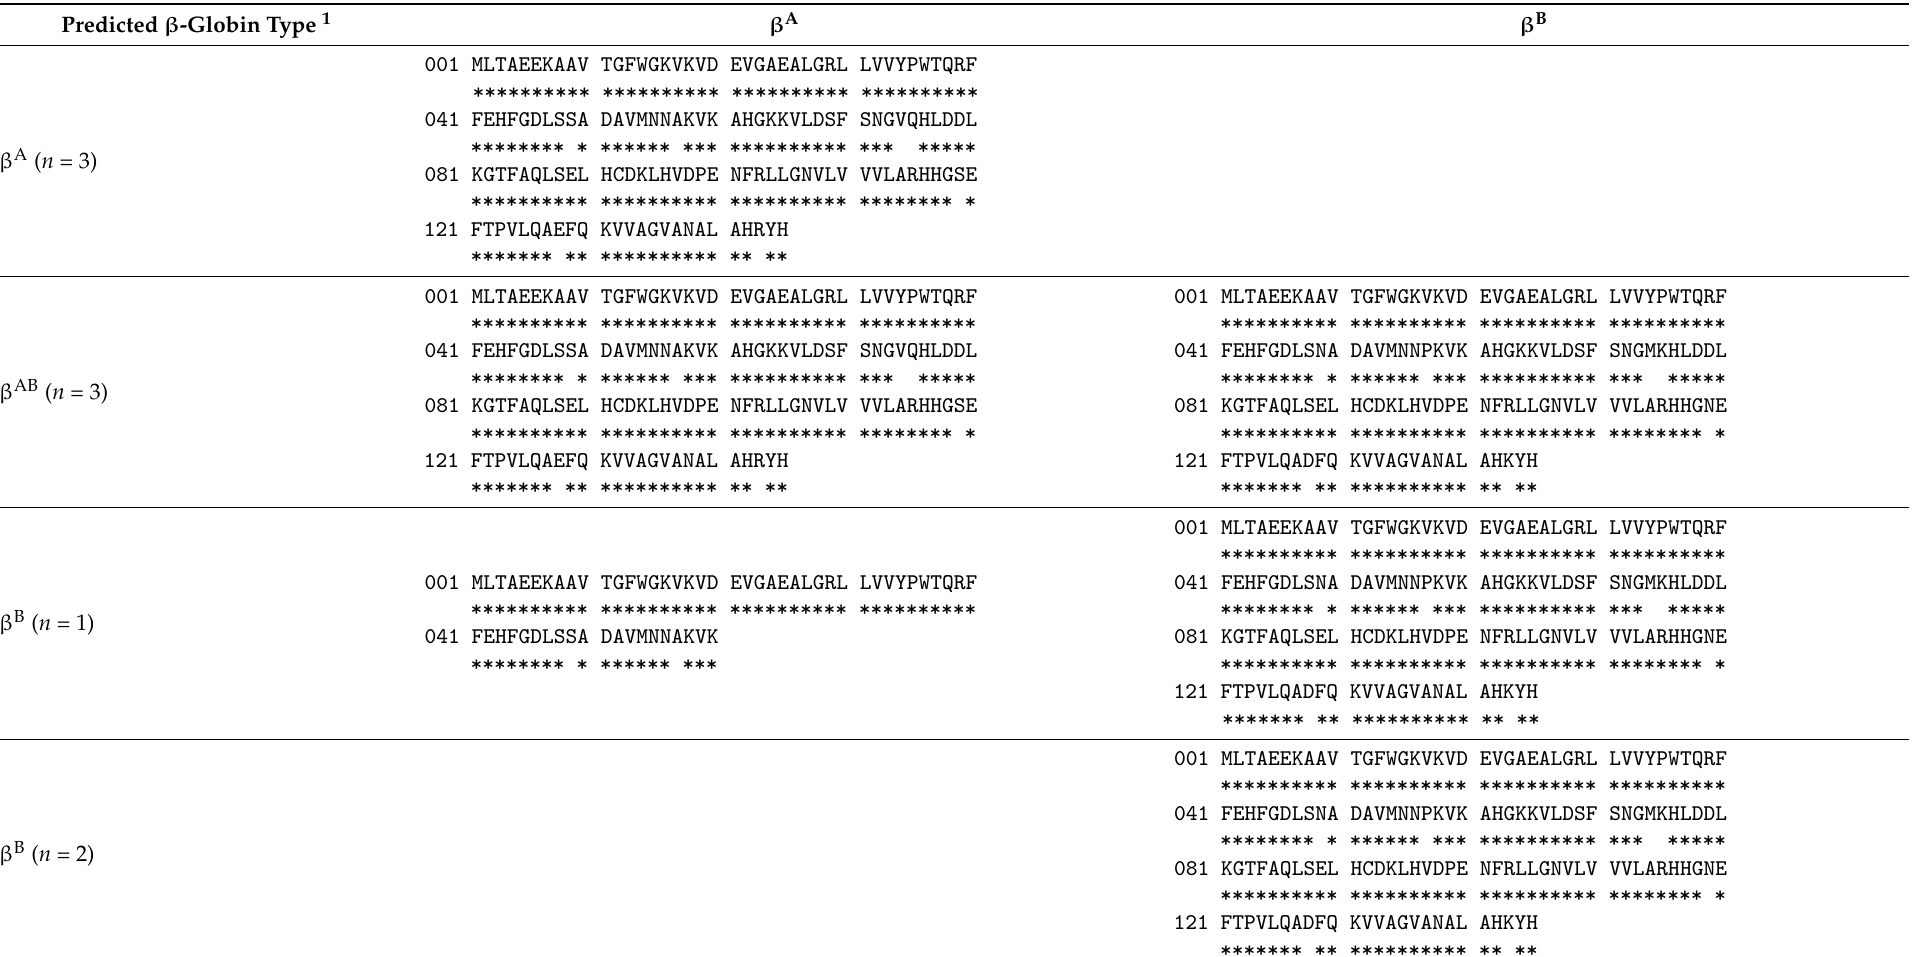
Table 4. Unique β -globin peptides detected by mass spectrometry from sheep blood samples from genotyped